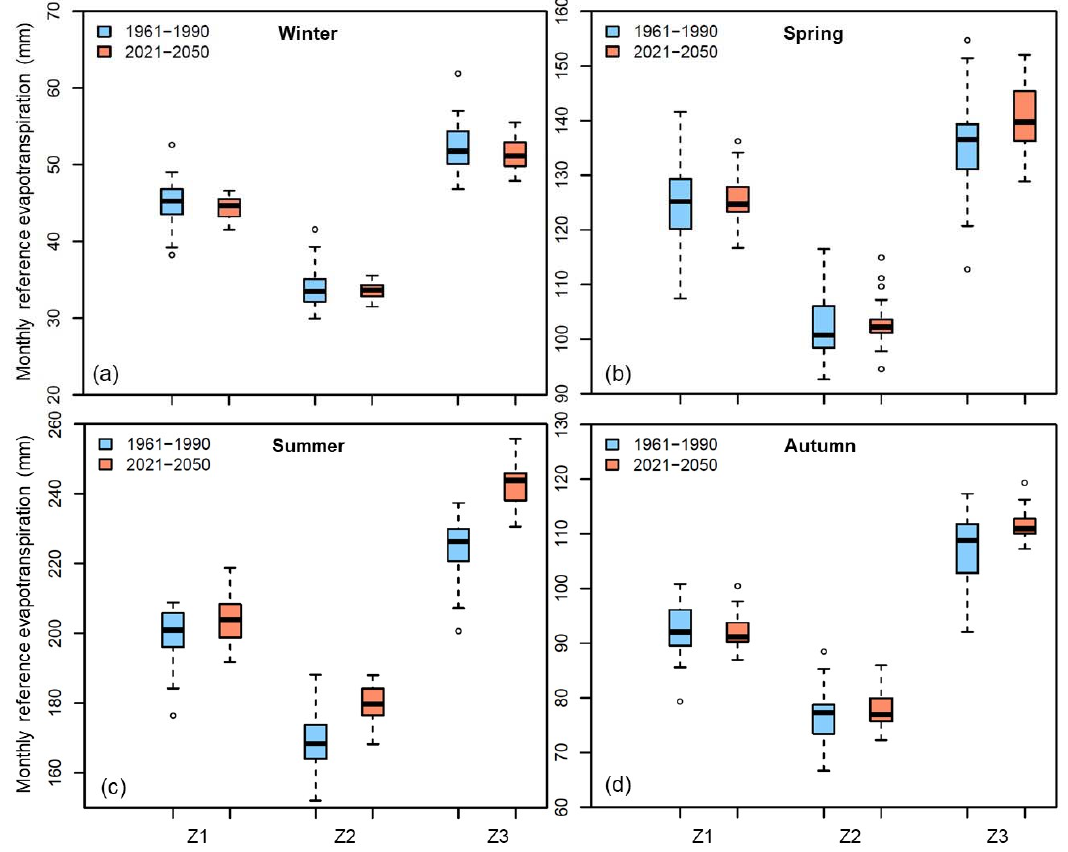
Figure 6. Boxplots of mean ETo simulated for time period 2021–2050 and from observational dataset for time reference period 1961–1990, for the Cantabrian coast (Z1), east of continental Spain (Z2), and Andalusian zone (Z3): ( a ) Winter, ( b ) Spring, ( c ) Summer, and ( d ) Autumn seasons.